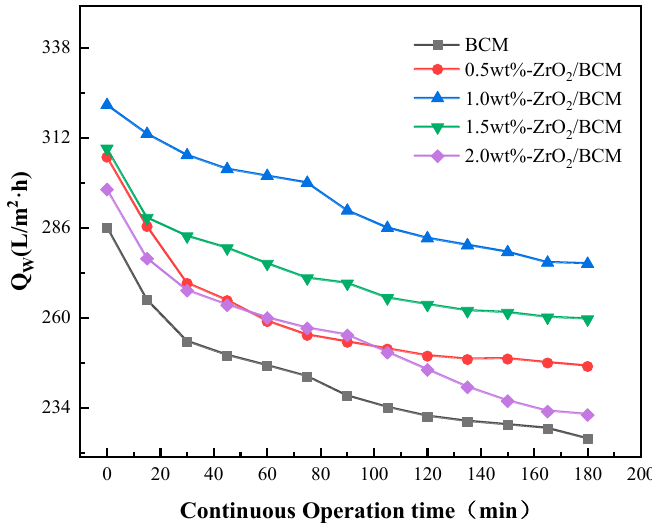
Figure 6. The influence of operation time on the change of membrane flux of BSA solution.